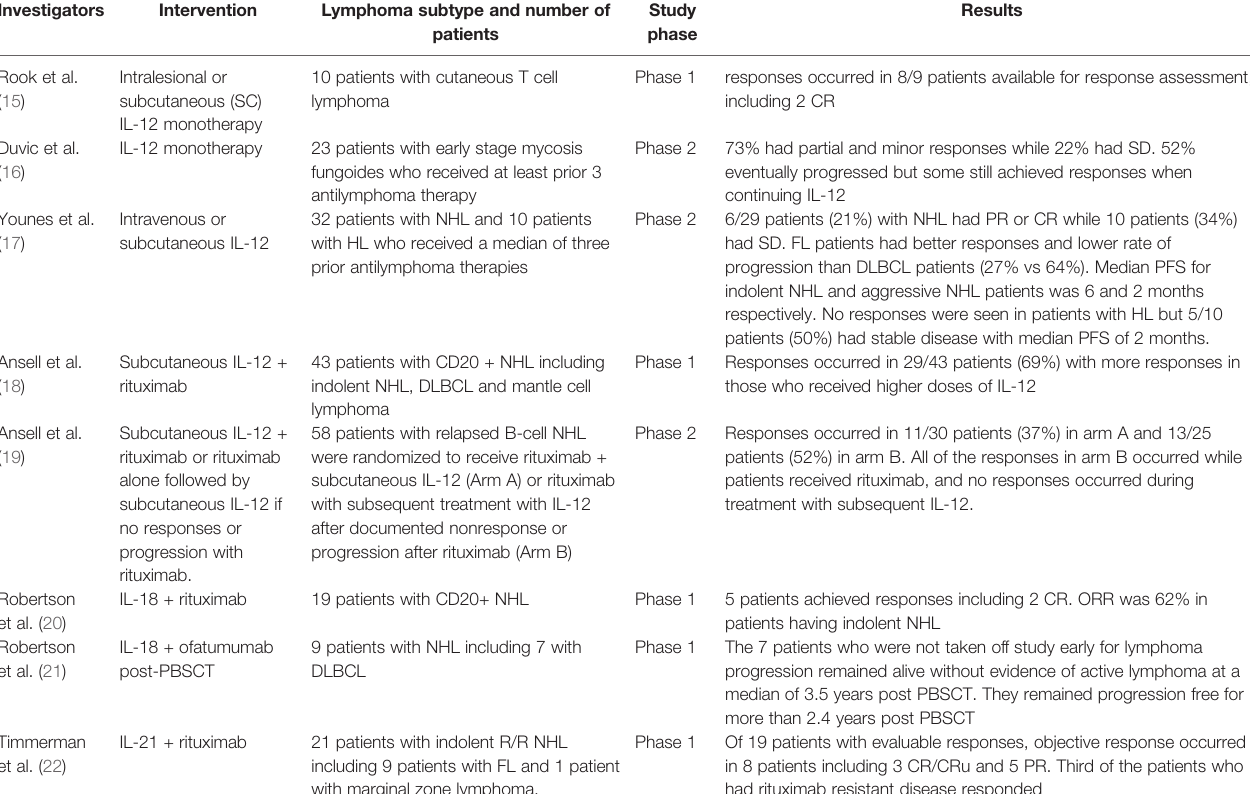
TABLE 2 | Cytokine-based Immunotherapy for Lymphoma: Clinical Trial Results. Investigators